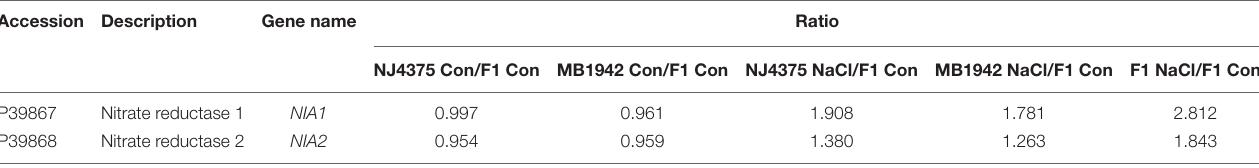
TABLE 1 | List of NO metabolism proteins in the three B. napus materials/seedling leaves in response to salt stress for 3